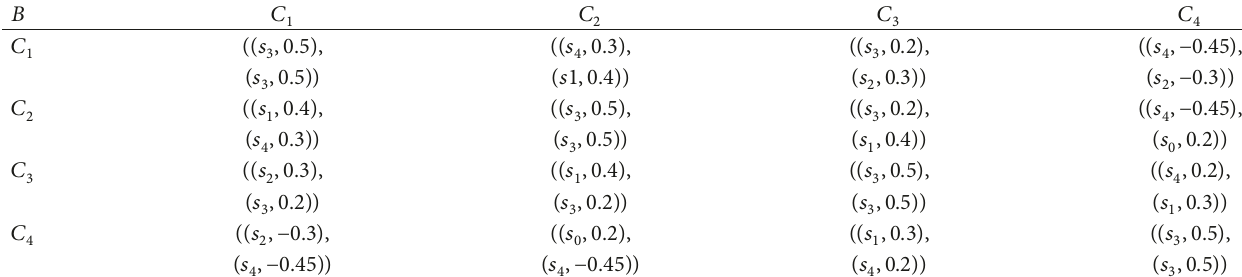
Table 2: I2TLPR of criteria concerning the overall